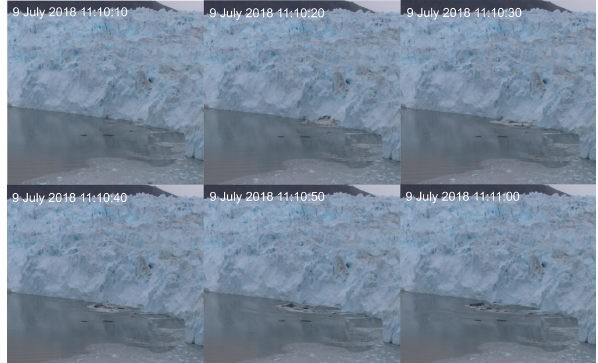
Figure 10. An example of a subaquatic calving event recorded with a time-lapse camera in 2018. Pictures were taken every